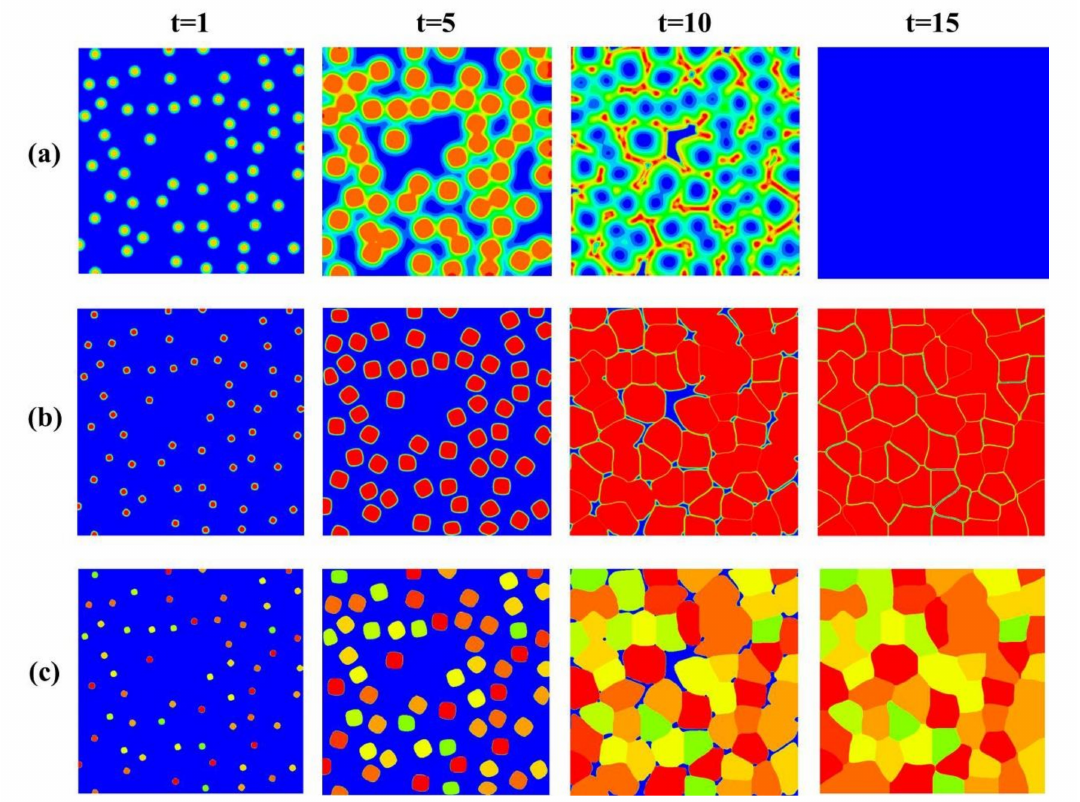
Figure 6. ( a ) Temperature distribution of equiaxed grains within flattened supersonic droplet during extremely rapid solidification; ( b ) Growth process of equiaxed grains; ( c ) Grains orientation at di ff erent